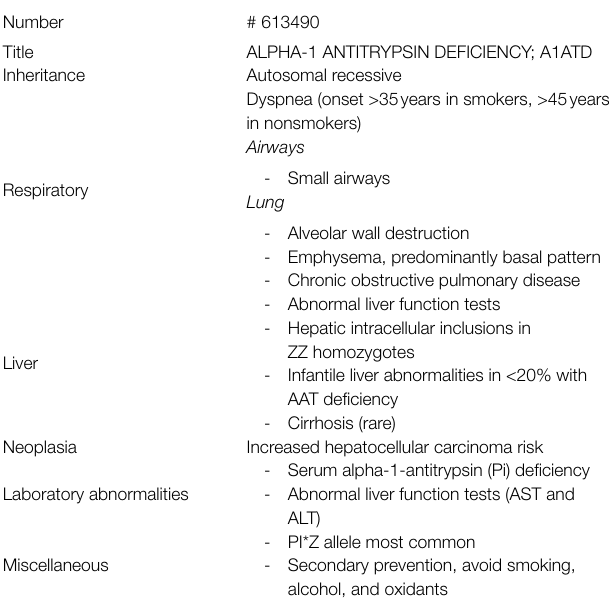
TABLE 3 | SERPINA1 clinical synopses (adapted from